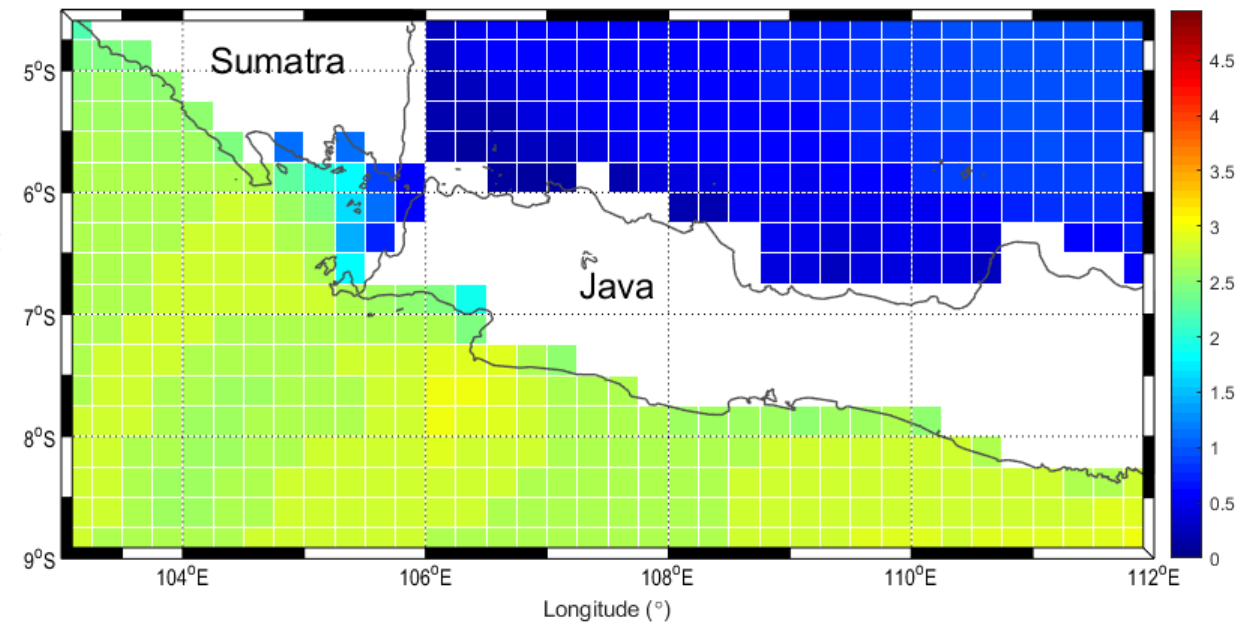
Figure 1. Snapshot of significant wave height from global forecast model GFS, with grid size of 0.25 ◦ . High-resolution wave prediction systems rely on detailed wind fields to run